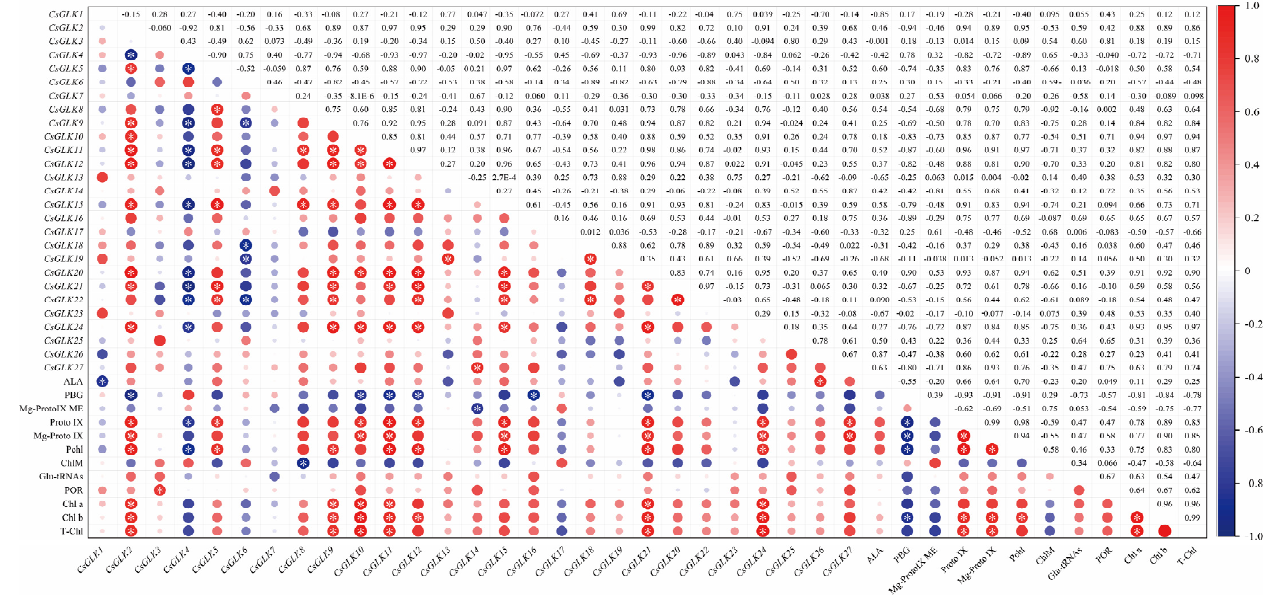
Figure 8. Correlation analysis. Color and size changes represented the degree of correlation. The larger the circular area and the darker the color, the stronger the correlation, and vice versa. Red represented negative correlations and blue represents positive correlations. * in the circular area means significant correlation ( p (cid:3409) 0.05).